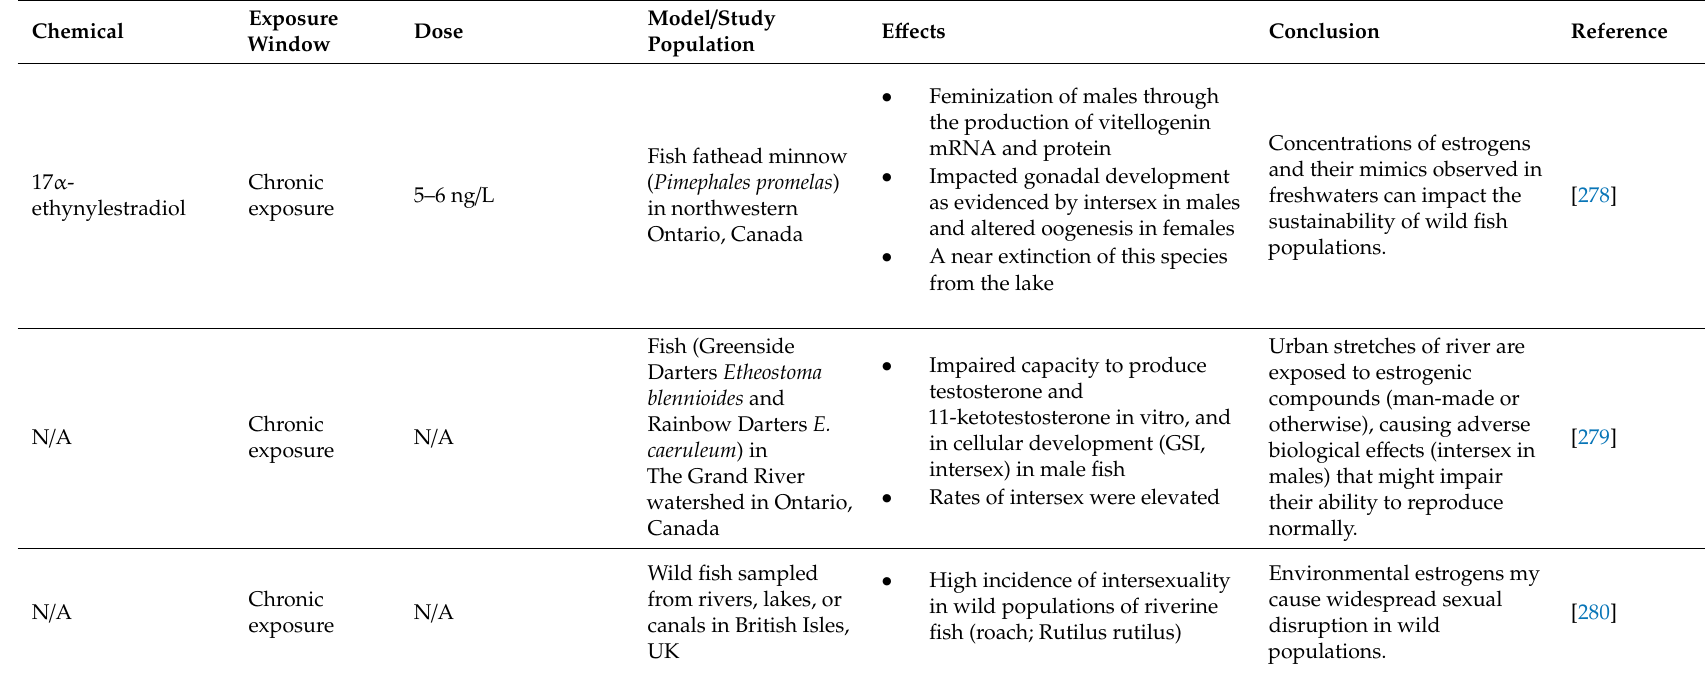
Table 8. E ff ects of Environmental Estrogens on the Reproductive